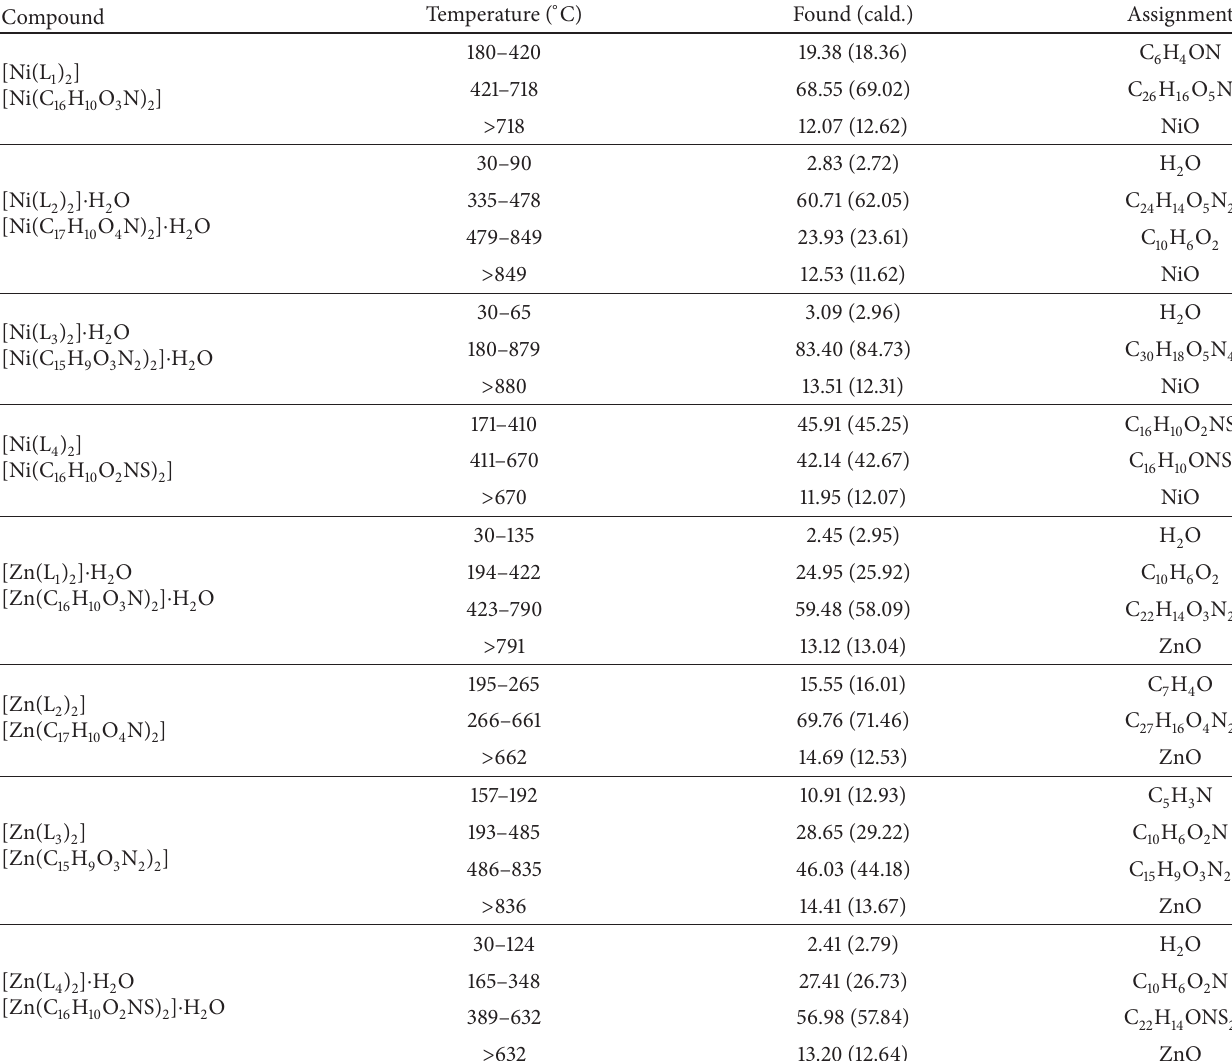
Table 4: Thermal analysis results of metal